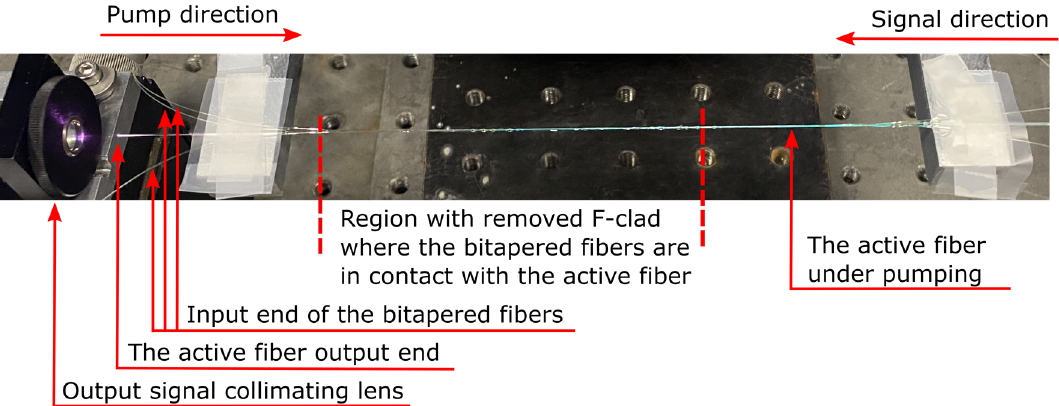
Figure 4. The developed side-pumped combiner on the Yb-doped tapered fiber under pumping with 976 nm 0.10 NA